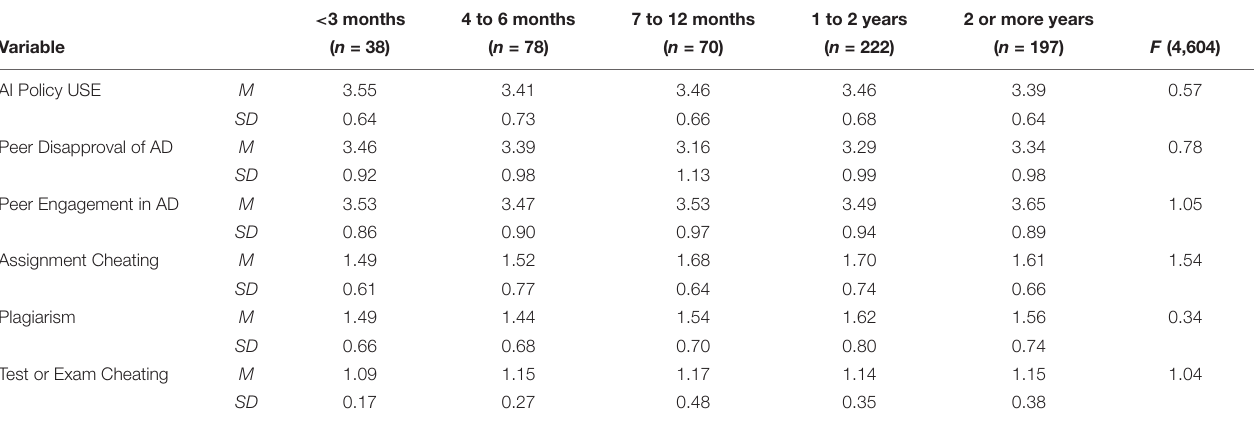
TABLE 8 | Results from ANOVA based on time elapsed since participants’ completion of the AI course. < 3